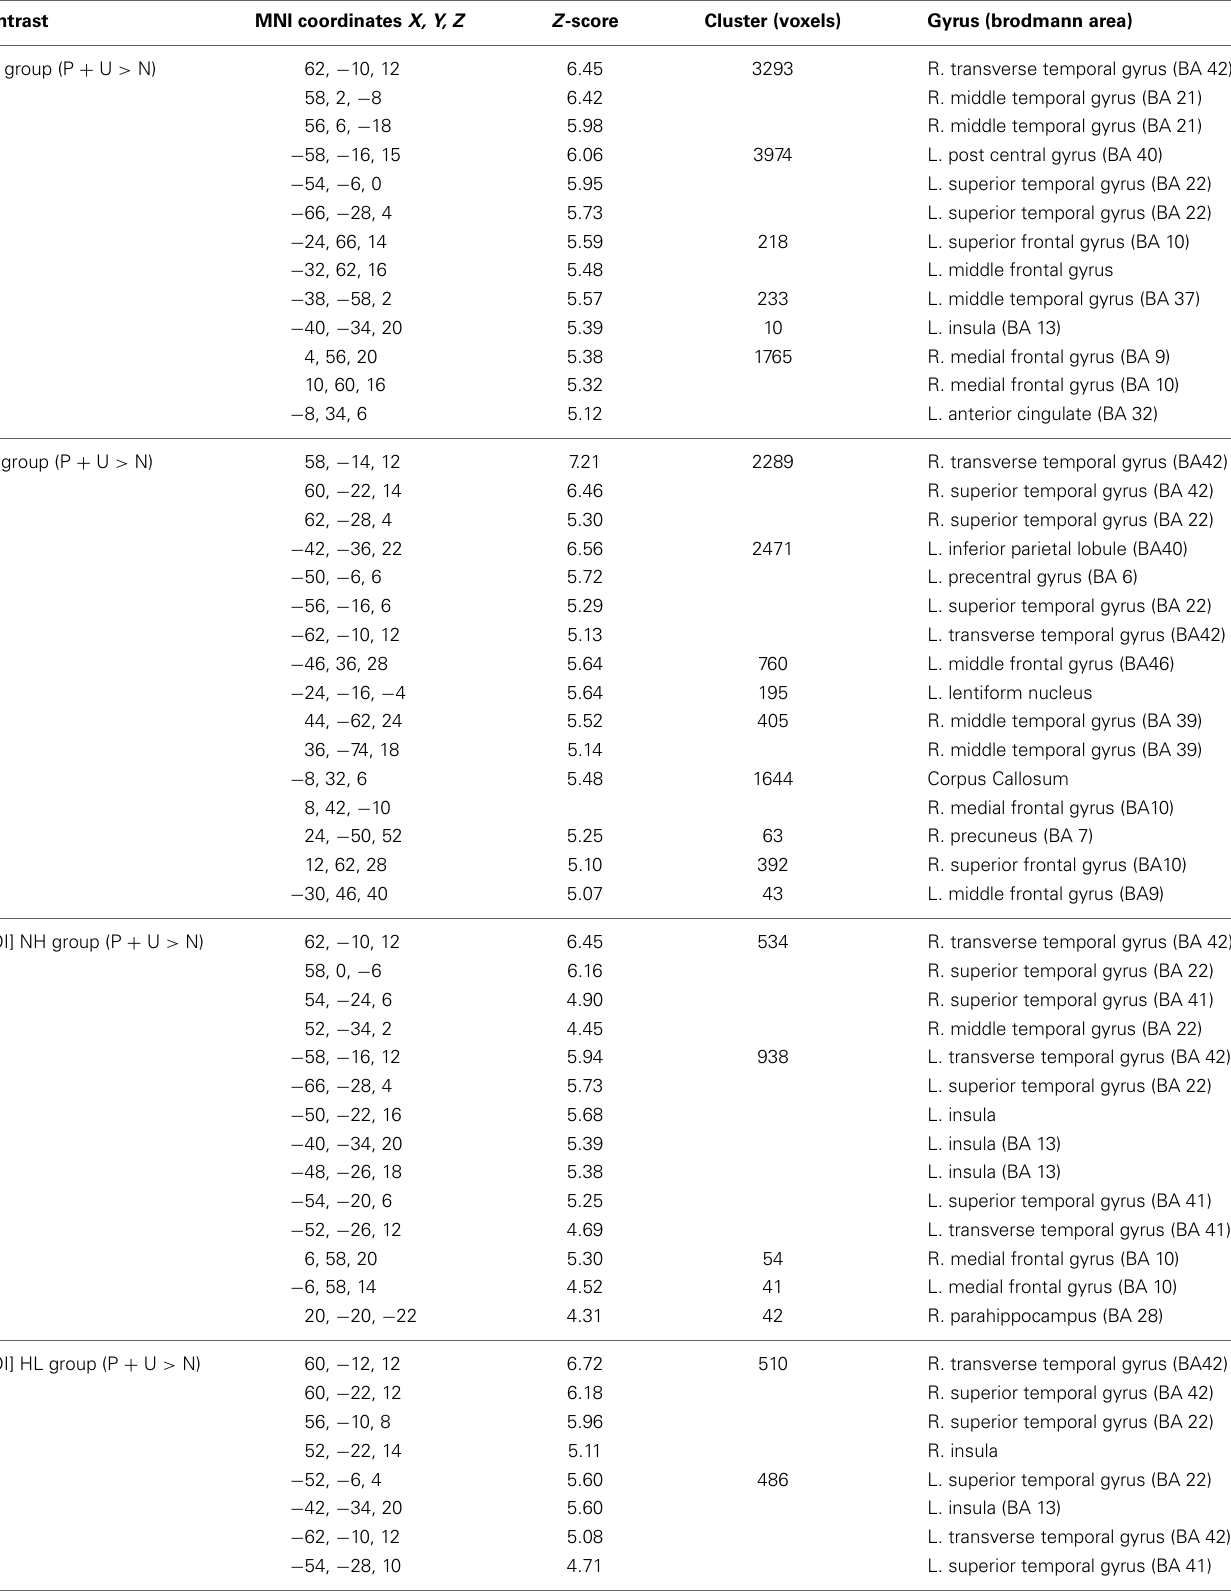
Table 3 | Local maxima for the P + U > N contrasts from the emotion task. Contrast MNI coordinates X, Y, Z Z -score Cluster